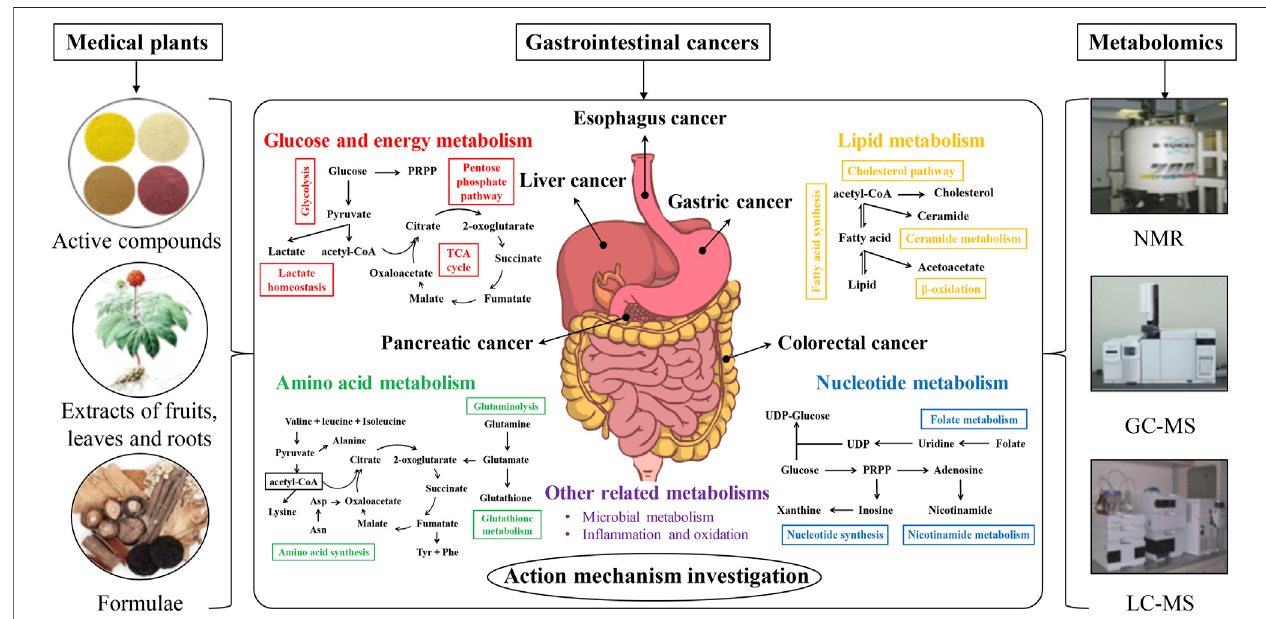
FIGURE1 | The schematic illustration ofaction mechanism investigation ofmedicinalplants in gastrointestinal cancer therapy from the metabolomics perspective.